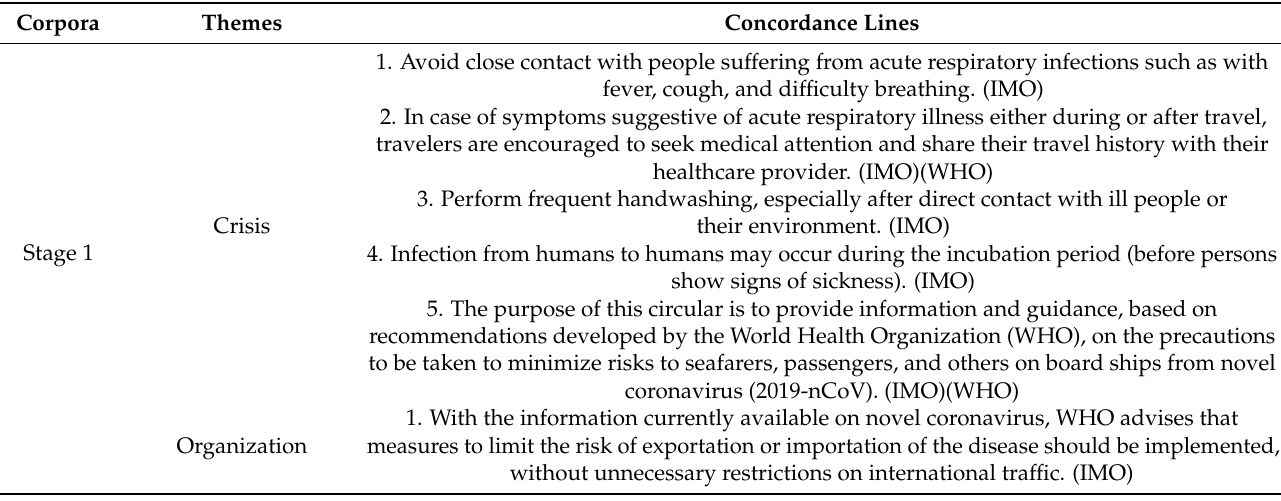
Table A2. Keyword-in-context: exemplary statements for the